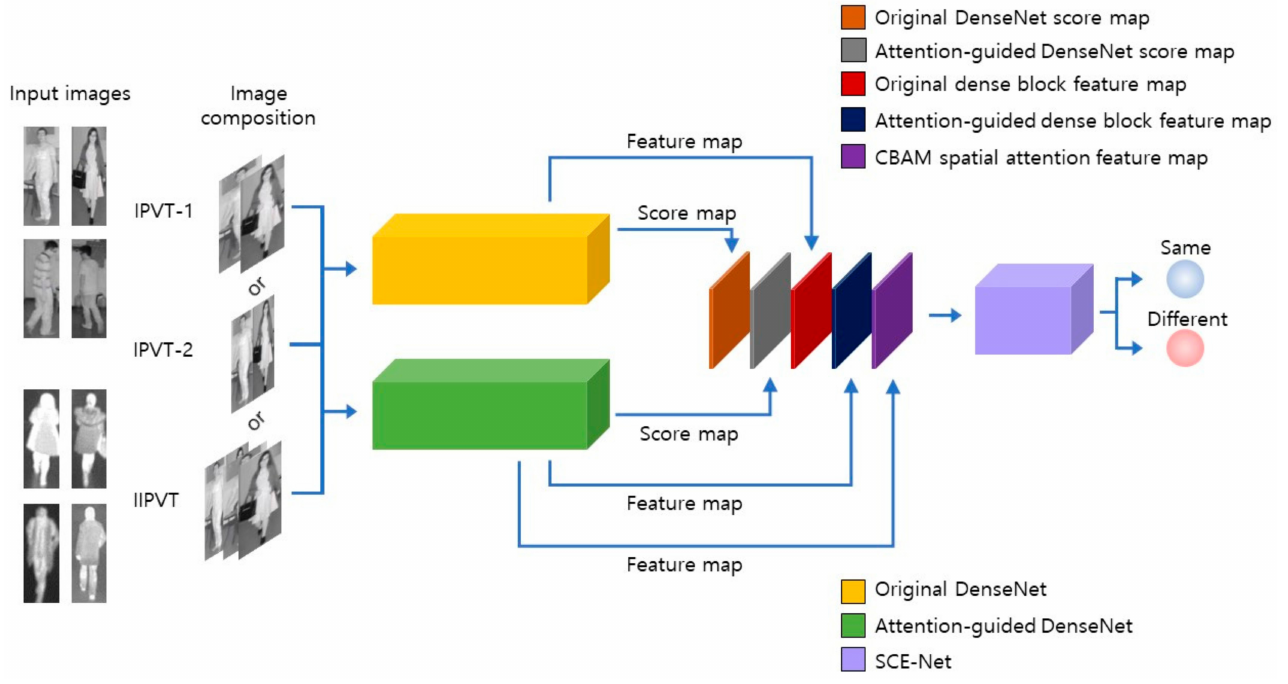
Figure 2. Architecture of OADE-Net. (IPVT-1: the inter-channel pair between the visible-light and thermal images; IPVT-2: intra-channel pair between the visible-light and thermal images; IIPVT: inter-channel and intra-channel pairs between the visible-light and thermal